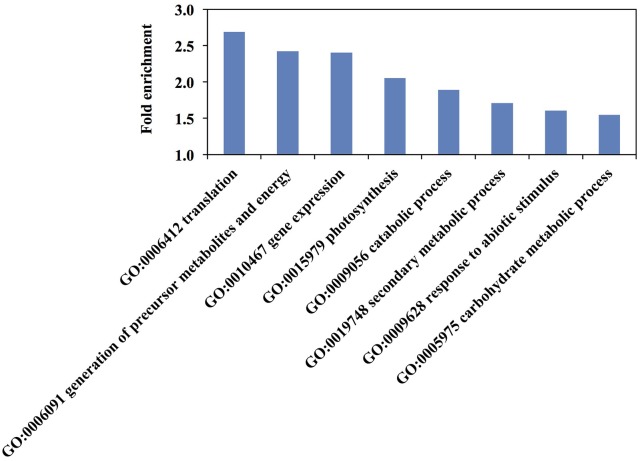
Top over-represented biological process Gene Ontology (GO) terms among rice elongating internode II proteins. Redundant GO terms were removed. All terms are over-represented with a p-value <0.01 by hypergeometric test. Fold enrichment is the ratio of identified proteins to the expected number of proteins for each GO term.